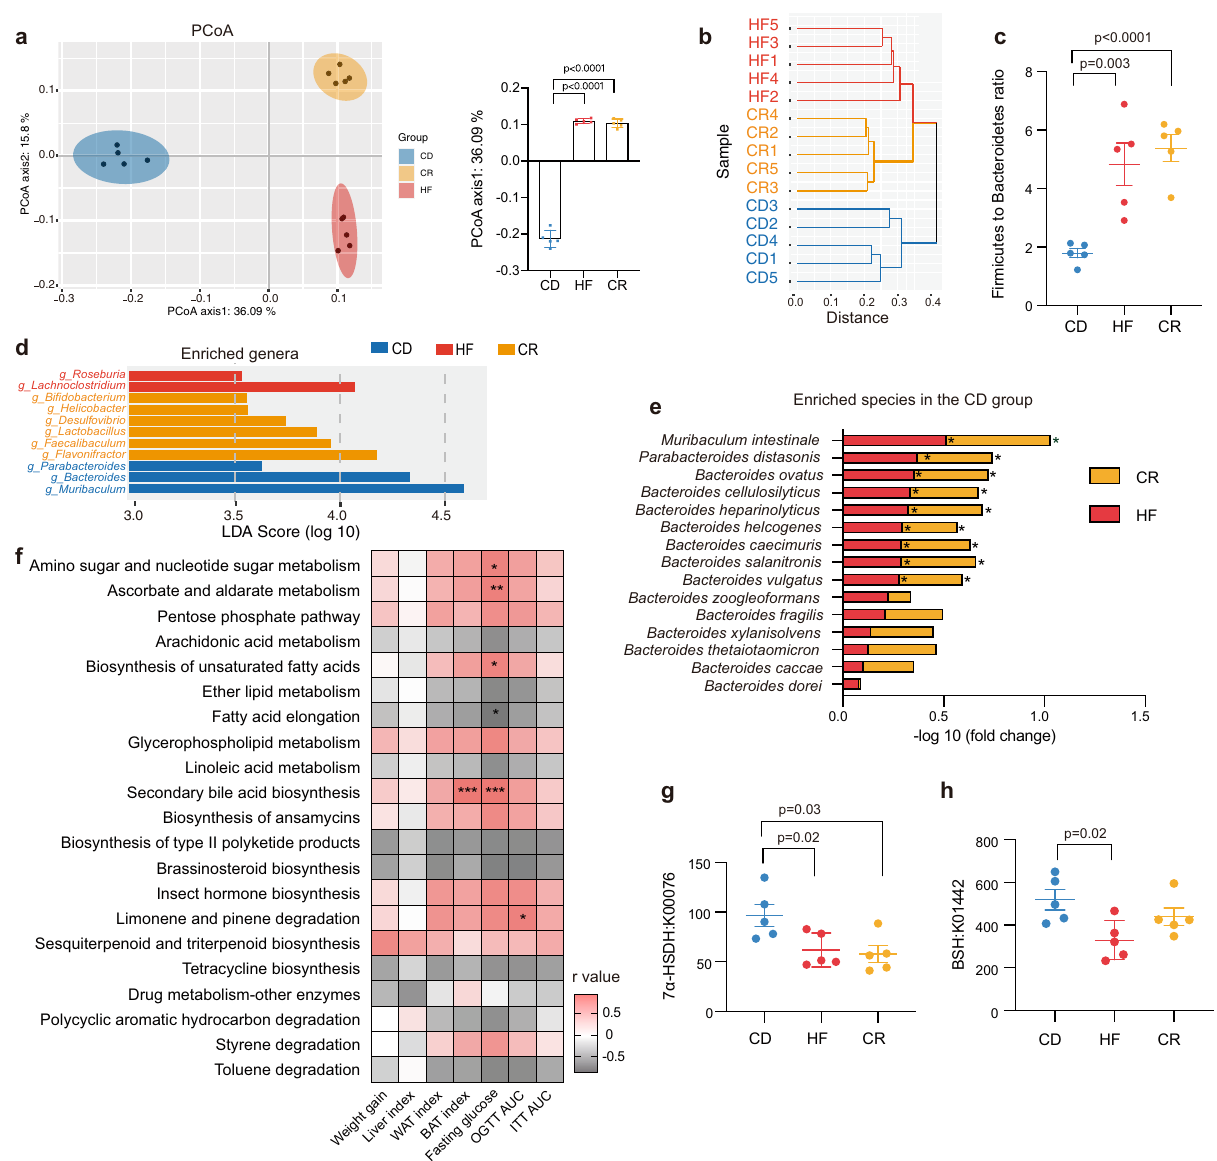
Fig. 2 Remodeling of gut microbiota under CR or HFD. a PCoA plot based on the Canberra similarity of cecal microbial composition. PCoA1 axis level of the three groups. b Hierarchical clustering based on the Canberra similarity among three groups. c The ratio of Firmicutes to Bacteroidetes among three groups. d LDA effect size method was performed to compare enriched taxa (levels of genus) in each group. The bar plot listed the signi fi cantly differential taxa (score >3.5) in HF, CR, and CD groups. e Fold change of the species enriched in the CD group with the most abundance. f Heatmap of correlation coef fi cients between the KEGG L3 pathway and phenotypes of the individuals with similar body weight before 4-week HFD by Spearman correlation. Each correlation coef fi cient smaller than − 0.8 or bigger than 0.8 was included in the plot, the p -values were adjusted by the method of Bonferroni. The color of each spot in the heatmap corresponds to the r value. g Relative abundance of the 7 α -HSDH (K00076) pathway. h Relative abundance of the BSH (K01442) pathway. n = 5 per group. Data are expressed as mean±SEM in the bar plots. All p -values in fi gures were calculated by the two-tailed unpaired T-test in the GraphPad software. Source data are provided as a Source data fi le. Oral glucose tolerance test (OGTT); insulin tolerance tests (ITT); area under the curve (AUC); epididymal white adipose tissue (WAT); brown adipose tissue (BAT); bile salt hydrolase (BSH); 7 α -hydroxysteroid dehydrogenase (7 α -HSDH); principal coordinate analysis (PCoA); linear discriminant analysis